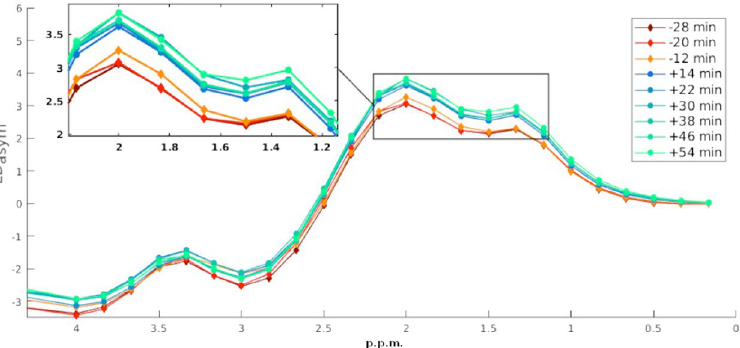
Figure 2. Asymmetry enhancement. Mean asymmetry fitted curves over the cortex region of a single WT mouse before and after 2DG injection. Highlighted by the square is the area where the cest enhancement has been evaluated.